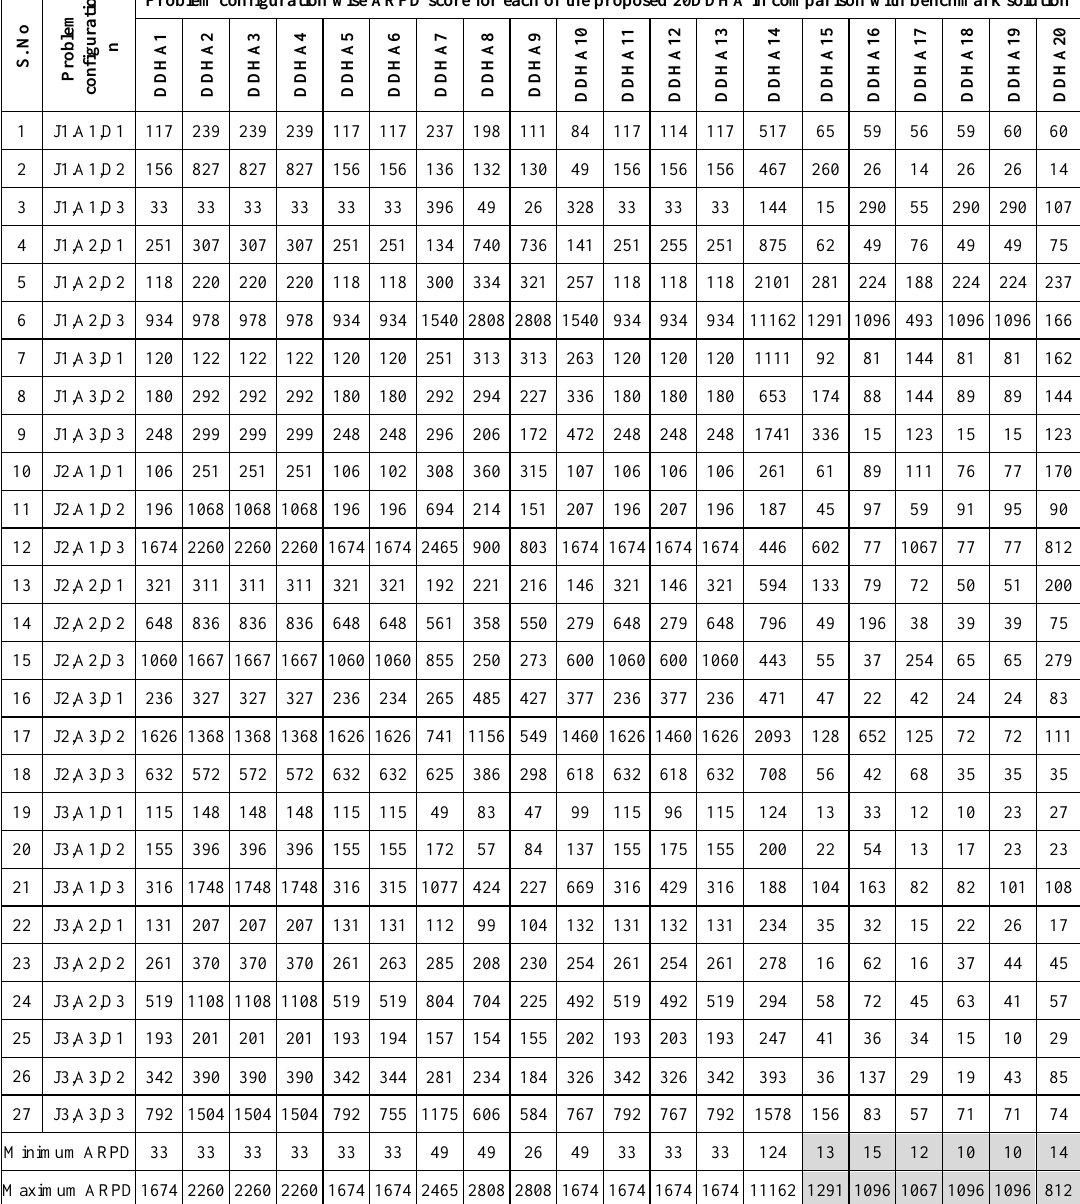
Table 3. Performance analysis of the proposed 20 variants of DDHA in comparison with estimated optimal solution. Problem configuration wise ARPD score for each of the proposed 20DDHA in comparison with benchmark